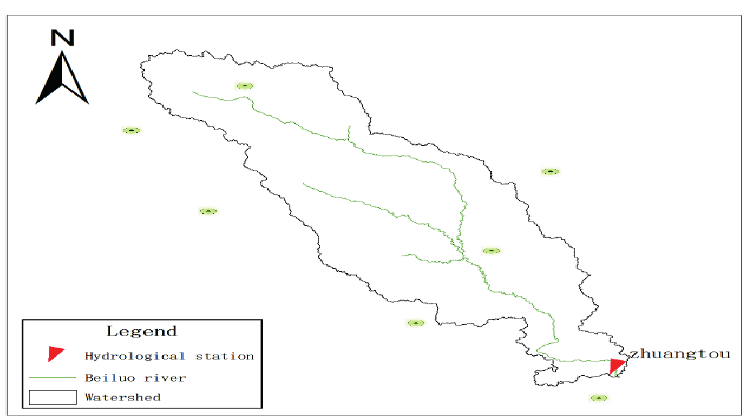
Fig. 1 Locations of the hydrological station and seven meteorological stations in and around